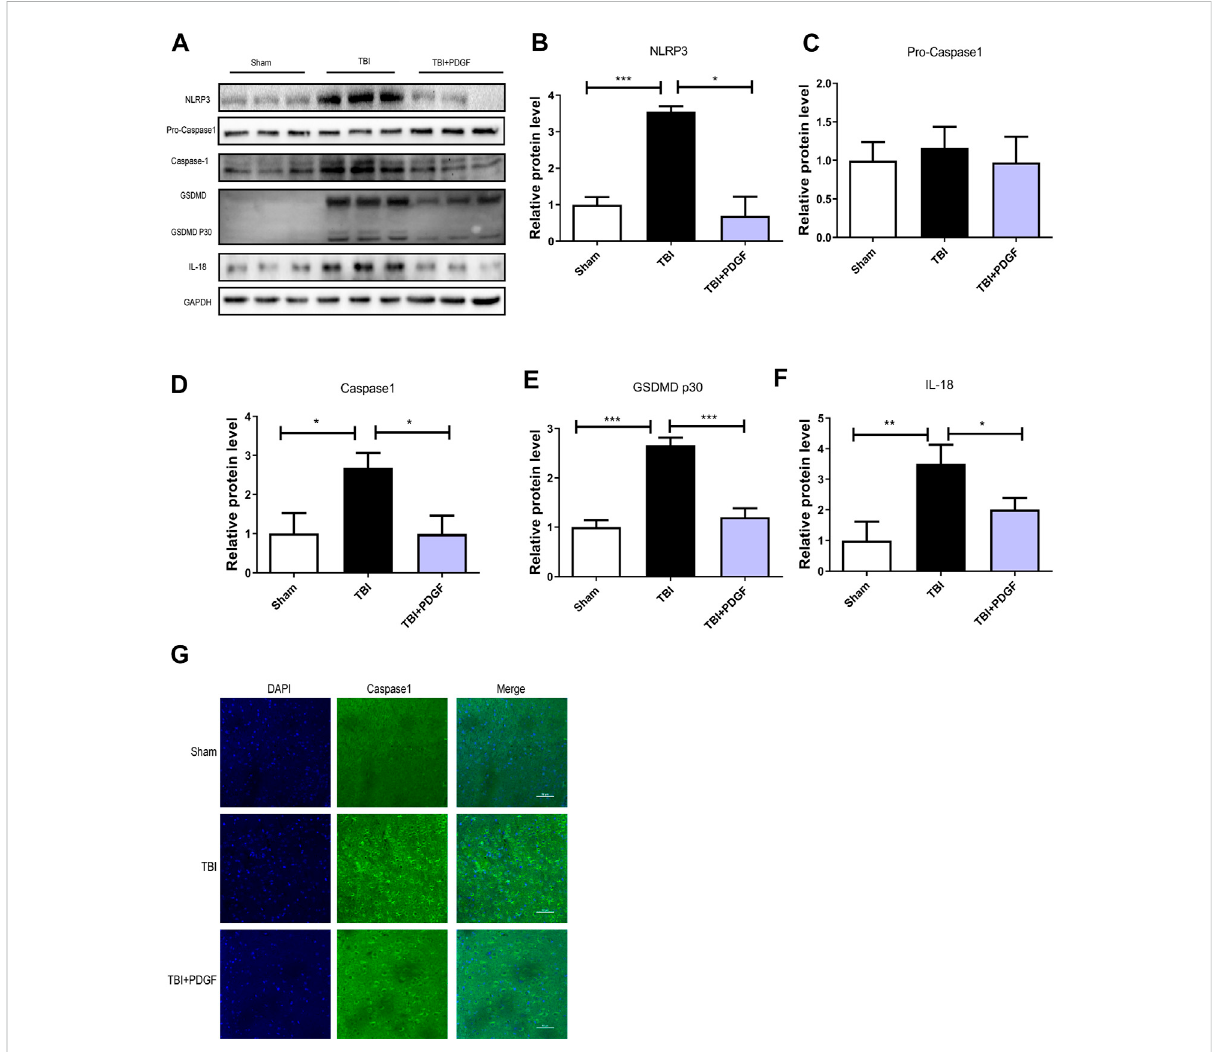
FIGURE 3 PDGF treatment reverses Pyroptosis after TBI. (A) Representative western blot analyses of NLRP3, Pro-caspase1, Caspase1, GSDMD, GSDMDP30 and IL-18 in the cerebral cortex at 3d after TBI. (B – F) Quanti fi cation of NLRP3, Pro-caspase1, Caspase1, GSDMDP30 and IL-18 in the ipsilateral brain cortex at 3d after TBI. Data represent the mean ± SD, n = 3, * p < 0.05, ** p < 0.01 and *** p < 0.001 vs. the indicated group. (G) Representation and quanti fi cation of immuno fl uorescence staining of Caspase1 (green) in the cortex at 3 days